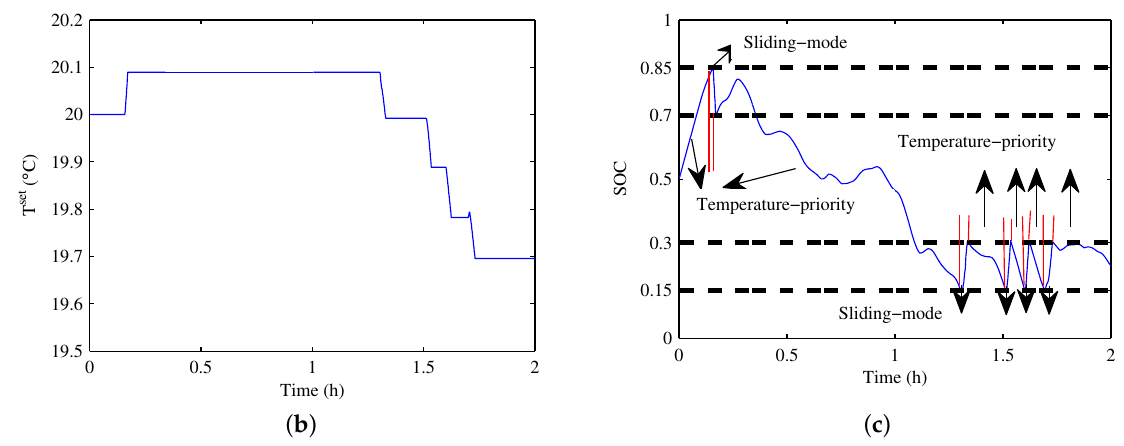
Figure 9. ( a ) AGC signal tracking; ( b ) temperature setpoint trajectory; ( c ) SOC of Switched Control II.